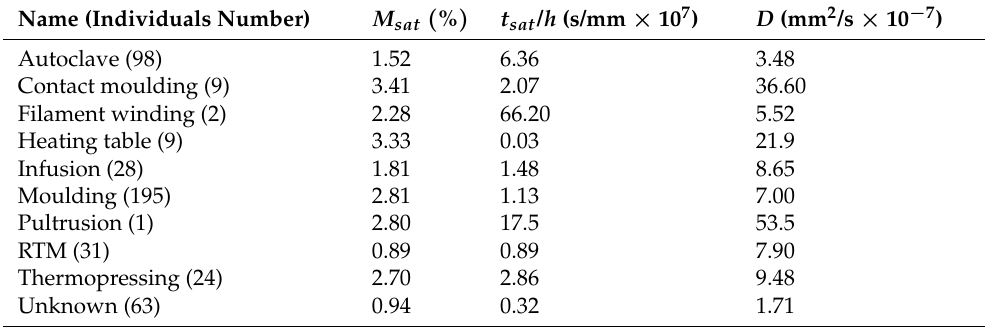
Table 6. Medians of M sat , t sat / h and D as a function of the process. Entire box plots are available as Supplementary Materials (Figures